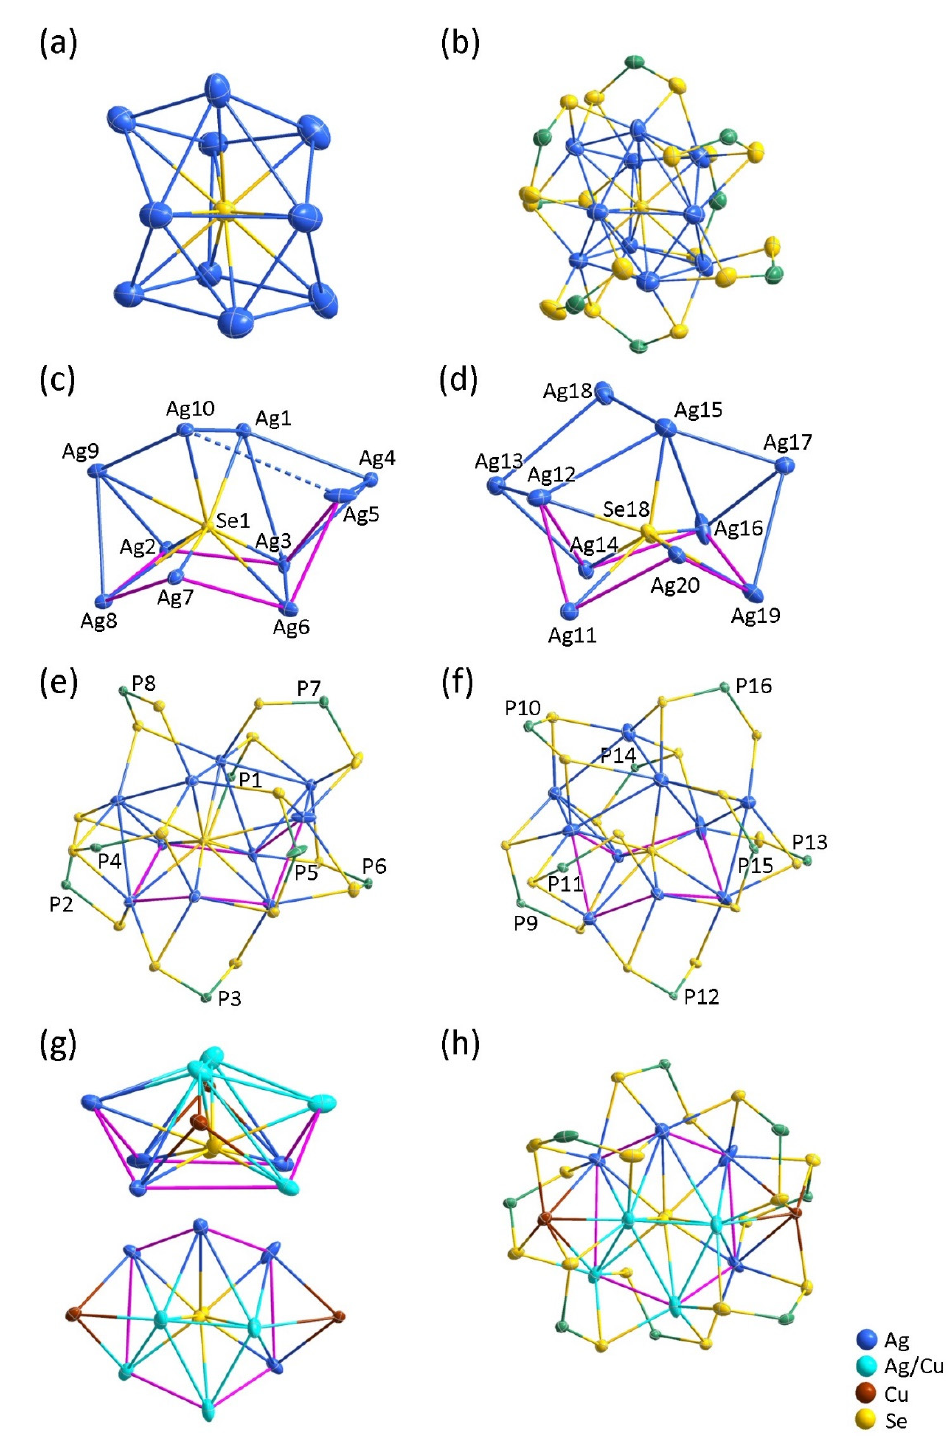
Figure 1. ( a ) The Ag 10 (Se) core and ( b ) the total structure of previously published [Ag 10 (Se){Se 2 P(OEt) 2 } 8 ] ( 1 ). ( c ) The Ag 10 (Se) cores of cluster A and ( d ) cluster B in newly characterized [Ag 10 (Se){Se 2 P(O i Pr) 2 } 8 ] ( 2 ). ( e ) The total structure of cluster A and ( f ) cluster B in 2 . ( g ) The Cu x Ag 10-x (Se) (x = 3.4) core and ( h ) the total structure of [ 3a ] 0.6 [ 3b ] 0.4 . (Thermal ellipsoid plots were drawn at 30% probability with isopropoxy groups omitted for clarity). Ag 10 (Se) framework in 1 . If the two Cu atoms in [ 3a ] 0.6 [ 3b ] 0.4 and the two Ag atoms from the back in 1 are removed, respectively, the leftover M 8 (Se) motifs are in similar atomic arrangement (Figure S2). Nevertheless, the arrangement of eight dsep